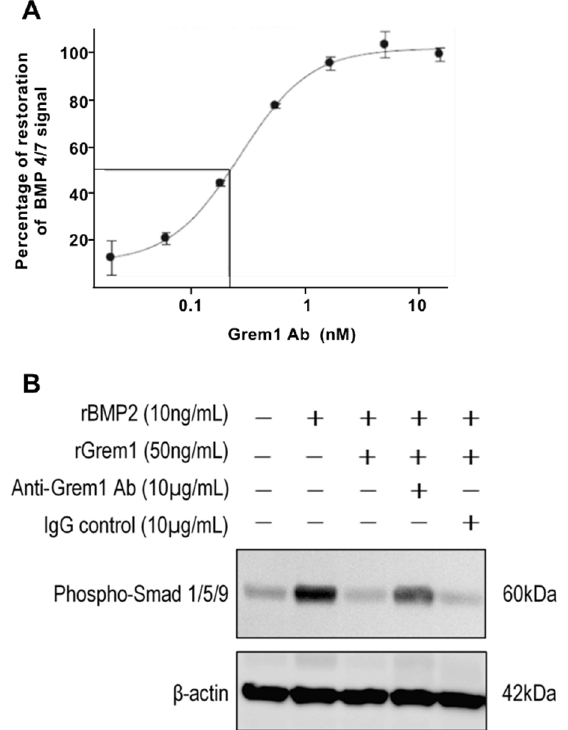
Figure 4. Anti-Grem1 antibody nullifies Grem1 inhibition of bone morphogenic protein (BMP) signaling. ( A ) Clone 12 cells were cultured with serial dilutions of anti-Grem1 antibody protein in the presence of a fixed amount of recombinant Grem1 protein and BMP heterodimer protein as part of a human embryonic kidney (HEK) Inhibitor of Binding Protein-1 (ID1) reporter assay. Data shown as percentage restoration of BMP 4 / 7 signal as measured by luciferase signal, relative to BMP4 / 7 signal in the absence of Grem1. ( B ) MDA-MB-231-TXSA cells were serum starved for 6 h, before stimulation for 2 h with combinations of recombinant BMP2 (rBMP2), recombinant Grem1 (rGrem1), anti-Grem1 antibody, and IgG isotype control antibody. Protein was immediately isolated from cells and analyzed by Western blot. BMP signaling was indicated by the amount of phospho- Mothers against decapentaplegic homolog (Smad) 1 / 5 / 9 protein relative to the loading control β -actin.